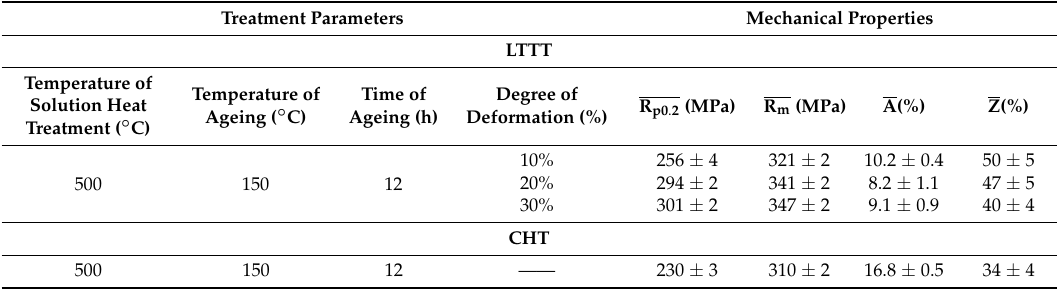
Figure 3. Influence of deformation degree on ( a ) strength and ( b ) plastic properties of the investigated alloy after LTTT. Table 1. Mechanical properties of the investigated alloy after the LTTT and conventional heat treatment